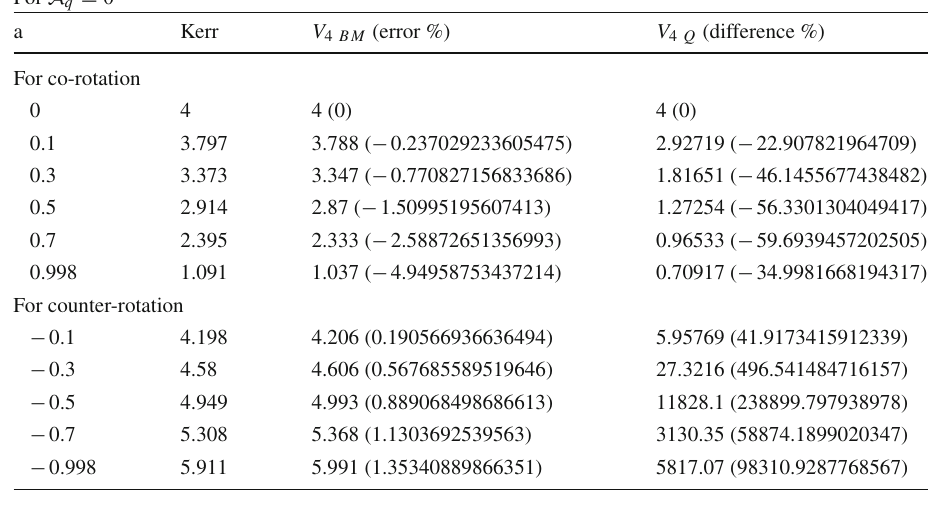
PNPs for very low DE effect in radiation era